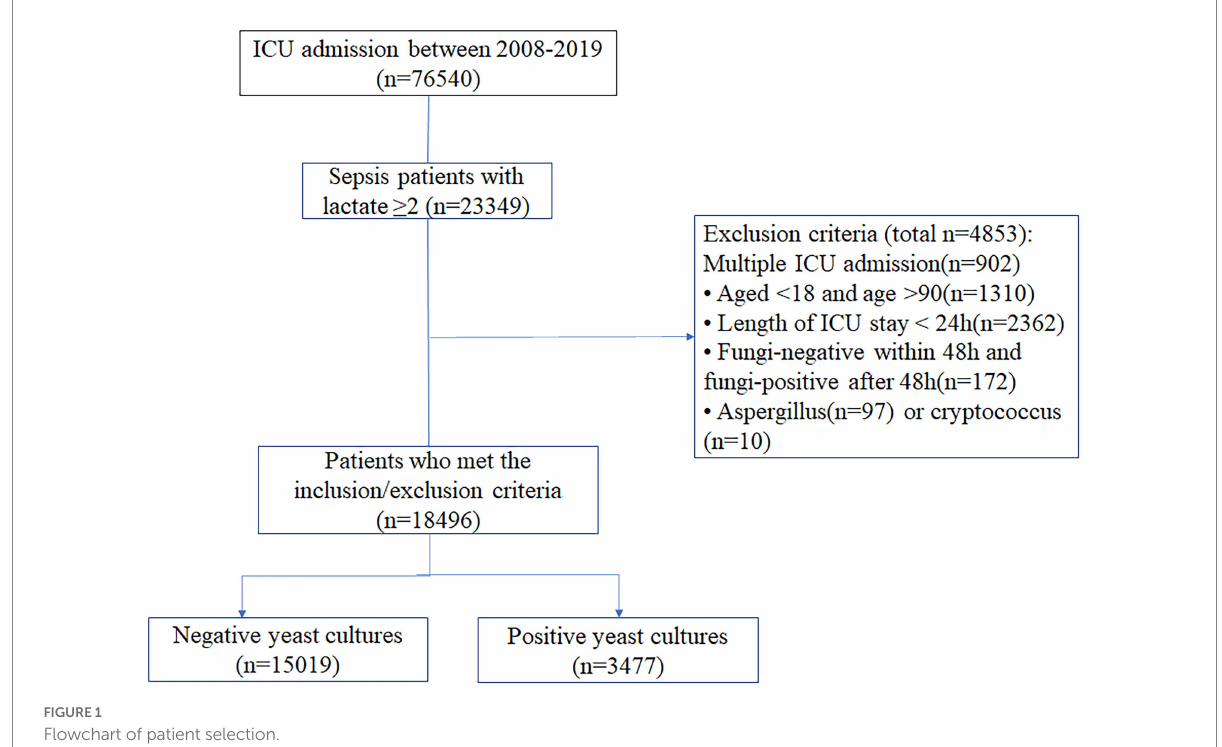
FIGURE 1 Flowchart of patient selection.